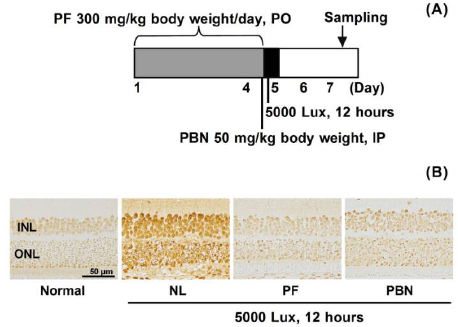
Figure 6. Inhibition of light-induced retinal cell apoptosis. ( A ) Experimental design ( n = 4). The